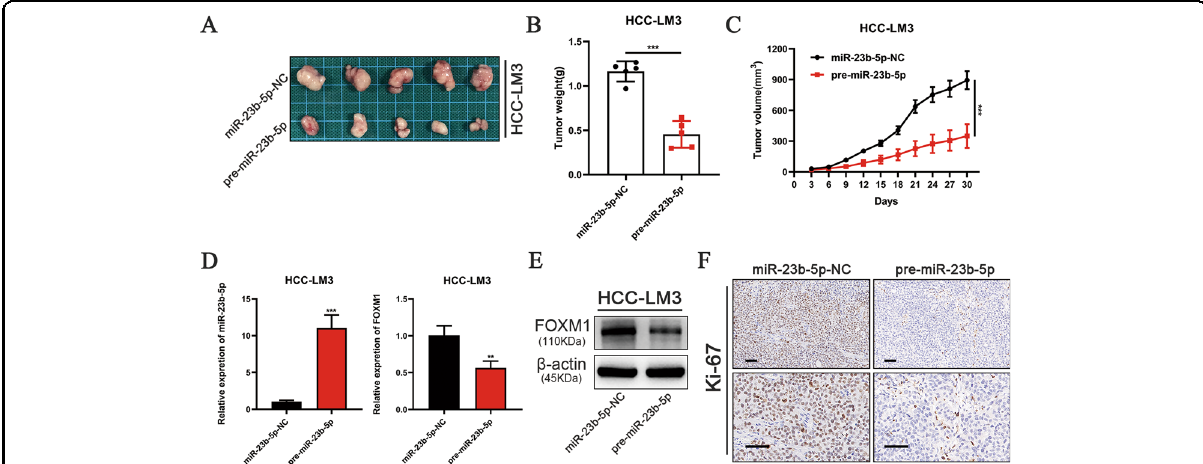
Fig. 5 miR-23b-5p suppresses xenograft tumor growth in vivo. A – C Photographs of tumors derived from the different groups of nude mice transfected with HCC-LM3-miR-23b-5p-NC and HCC-LM3-pre-miR-23b-5p cells. The tumors were measured for volume and average weight. D The miR-23b-5p and FOXM1expression levels of xenografts were analyzed by qRT-PCR. E The FOXM1 expression levels of xenografts were detected by western blot. F Ki67 staining of tumor tissues mice injected with HCC-LM3-miR-23b-5p-NC and HCC-LM3-pre-miR-23b-5p cells (scale bars, 50 μ m). All data are presented as the mean ± S.E.M. (* P < 0.05, ** P < 0.01, and *** P <